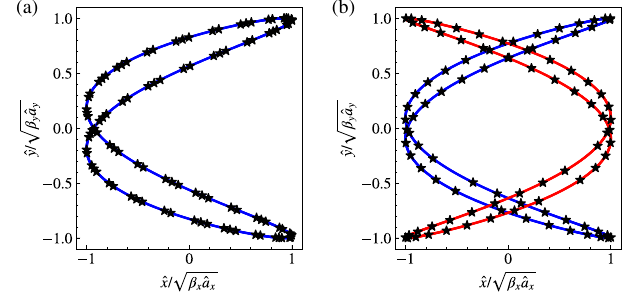
FIG. 7. In (a) is shown an example of a fixed line for N x ¼ 1 , N 2 , and m ¼ 19 . The blue curve corresponding to l ¼ 0 is y ¼ the theoretical curve, and the black markers signal the location of the beam during 100 turns. (b) shows the case with N x ¼ 2 , N 4 , and m ¼ 19 : Here in the plane x − y there are two y ¼ distinct parametrizing curves (blue for l ¼ 0 and red for l ¼ 1